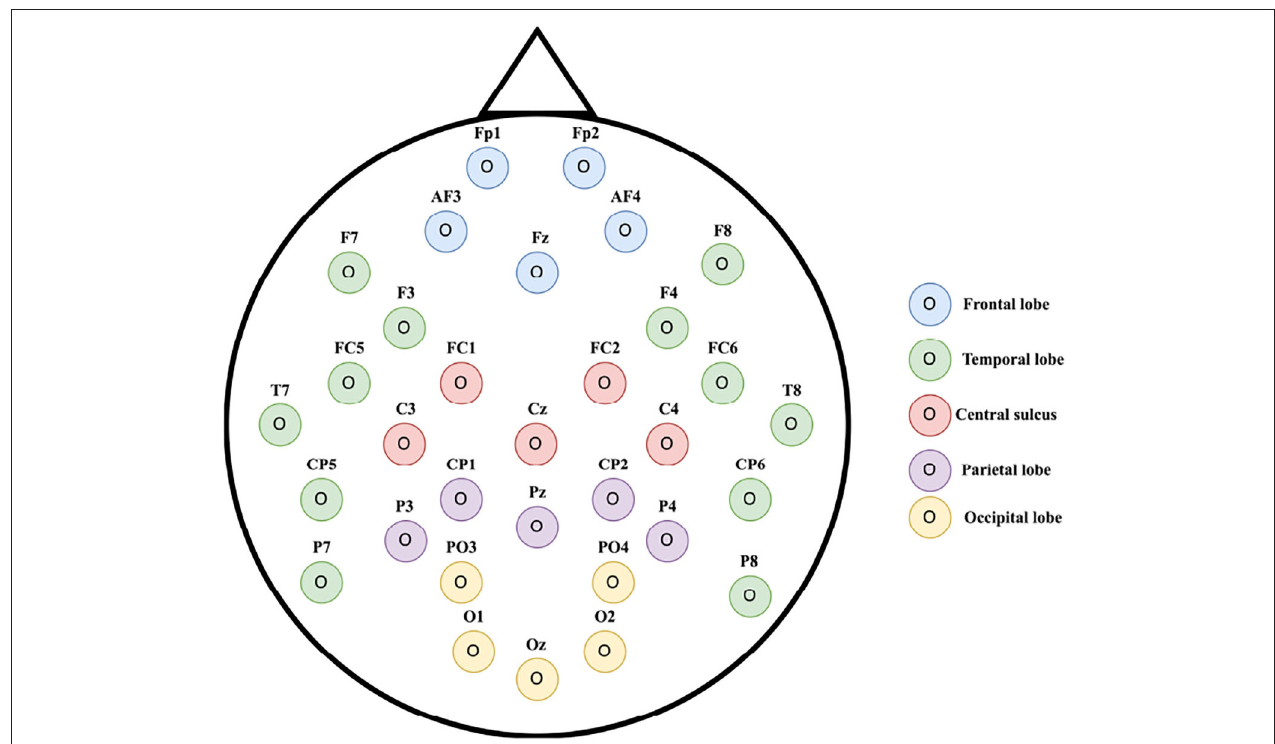
FIGURE 3 | Feature selection on electrode placement of 32 channel Electroencephalographic (EEG) according to the international 10-20 system (best seen in color) (Alarcão and Fonseca, 2019).